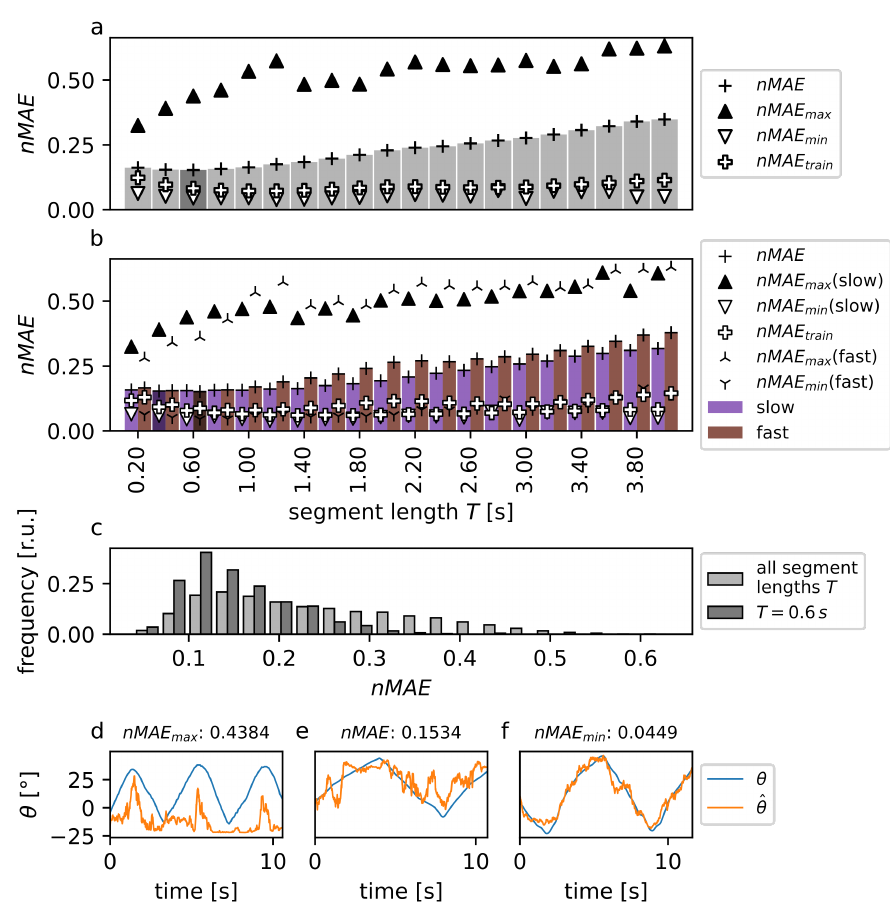
Figure 6. Average prediction performance of FFNN models trained with different segment lengths T using the IEMG feature with no offset δ and an overlap corresponding to a 100Hz feature signal frequency. ( a ) Mean absolute errors for elbow motion prediction based on different segment lengths T = [0.2s. . . 4.0s] with a step size of 0.2s. The different symbols depict the prediction error ( nMAE ) using the test data set ( black plus sign ), the corresponding minimum ( nMAE min ; white arrow ) and maximum ( nMAE max ; black arrow ) prediction errors, as well as the prediction errors for the training data set ( nMAE train ; white plus sign ). ( b ) Mean absolute errors as in ( a ), but separated based on slow (purple bars) and fast (brown bars) movement speed condition. Minimum and maximum prediction errors are depicted via symbols as described in the corresponding legend. ( c ) Normalized frequency distribution of prediction errors using the IEMG feature for all segment lengths T (light gray bars) and a segment length of ( T =) 0.6s (dark gray bars), which yielded the highest predictive accuracy ( dark gray color in ( a ) ). ( d – f ) Exemplary plots of an experimentally recorded elbow-joint angle θ ( blue ) and the corresponding model prediction ˆ θ ( orange ) based on the IEMG feature with a segment length of ( T =) 0.6s: ( d ) prediction with the highest prediction error ( nMAE max = 0.4384), ( e ) model prediction closest to the mean prediction error ( nMAE = 0.1534) and ( f ) model prediction with the lowest prediction error ( nMAE min =